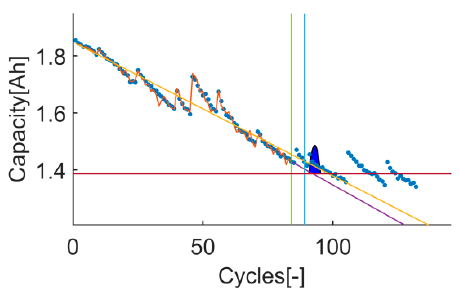
Figure 25. Time-instant figure of test 2 on t 78 .